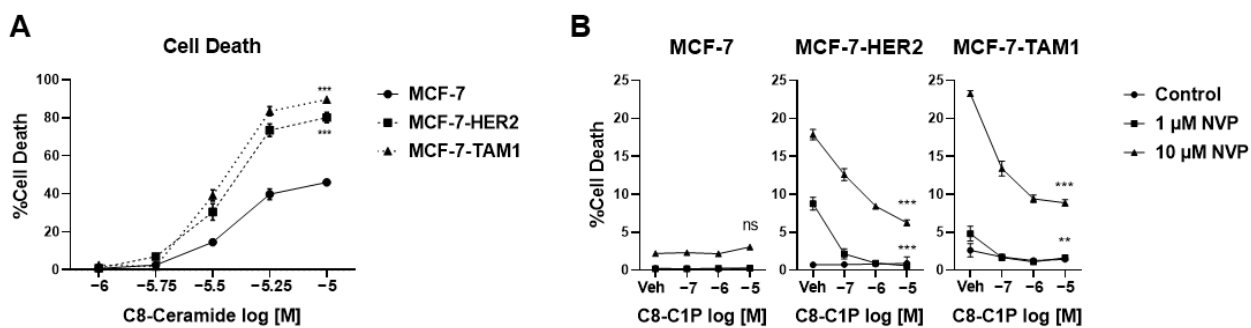
Figure 5. Tamoxifen-resistant cells are more sensitive to changes resulting from CERK inhibition. ( A ) MCF-7, MCF-7-HER2, and MCF-7-TAM1 cells were treated with increasing doses of C8-ceramide for 48-h and cell death was analyzed by Hoechst-PI staining. ( B ) C8-C1P was added to MCF-7, MCF-7-HER2, and MCF-7-TAM1 cells treated with NVP-231. After 48-h of treatment, cell death was measured by Hoechst-PI endpoint assay. ns: not significant, ** p < 0.01, *** p < 0.001. To investigate whether the product of CERK, C1P contributes to the differential sen- sitivity to CERK inhibition, we performed a lipid addback experiment in which cells were treated with NVP-231 and increasing concentrations of C8-C1P. We observed that C8-C1P partially reversed CERK inhibition-induced cell death in tamoxifen-resistant cells (Figure 5B) but had little to no effect in parental MCF-7 cells, suggesting that reduced C1P can also contribute to CERK inhibition-induced cell death. Since C1P has been shown to downregulate ceramide levels by inhibiting the activity of serine palmitoyl transferase (SPT) [55], the rate-limiting enzyme for de novo ceramide biosynthesis [56], we examined how C1P addback affected ceramide levels in the MCF-7- HER2 cells. We found that C1P partially reverses the increase in ceramide levels induced by NVP-231 treatment (Figure 6A,B). Taken together, these findings support the concept that ET-resistant cells are more sensitive to CERK inhibition because they are more sensi- tive to ceramide-induced cell death and that one of the ways C1P promotes tamoxifen- resistant cell survival is by maintaining low endogenous ceramide levels. Figure 6. C1P addback partially reverses NVP-mediated ceramide increases. ( A ) MCF-7-HER2 cells were treated with 1 µM NVP-231, 1 µM C8-C1P, or a combination of NVP-231 and C8-C1P for 48- h. Abundance of all ceramide species relative to the vehicle-treated control was determined by LC- MS and is presented as a heatmap. ( B ) Total ceramide levels were calculated by dividing the abun- dance of all ceramide species by the average abundance of all ceramides in vehicle-treated controls and are presented as fold changes compared to vehicle-treated control in a bar plot. ns: not signifi- cant, *** p < 0.001.